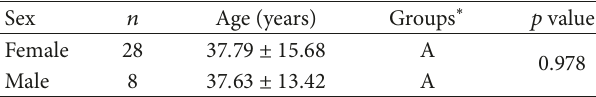
Figure 4: Distribution of the sample according to sex and articular eminence morphology. Table 1: Analysis of the comparison between